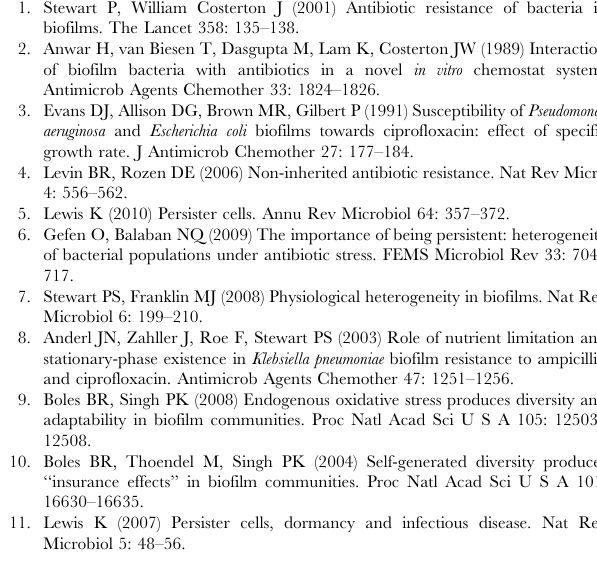
Table S1 Bacterial strains and plasmids used in this study. Table S2 Oligonucleotide primers used in this